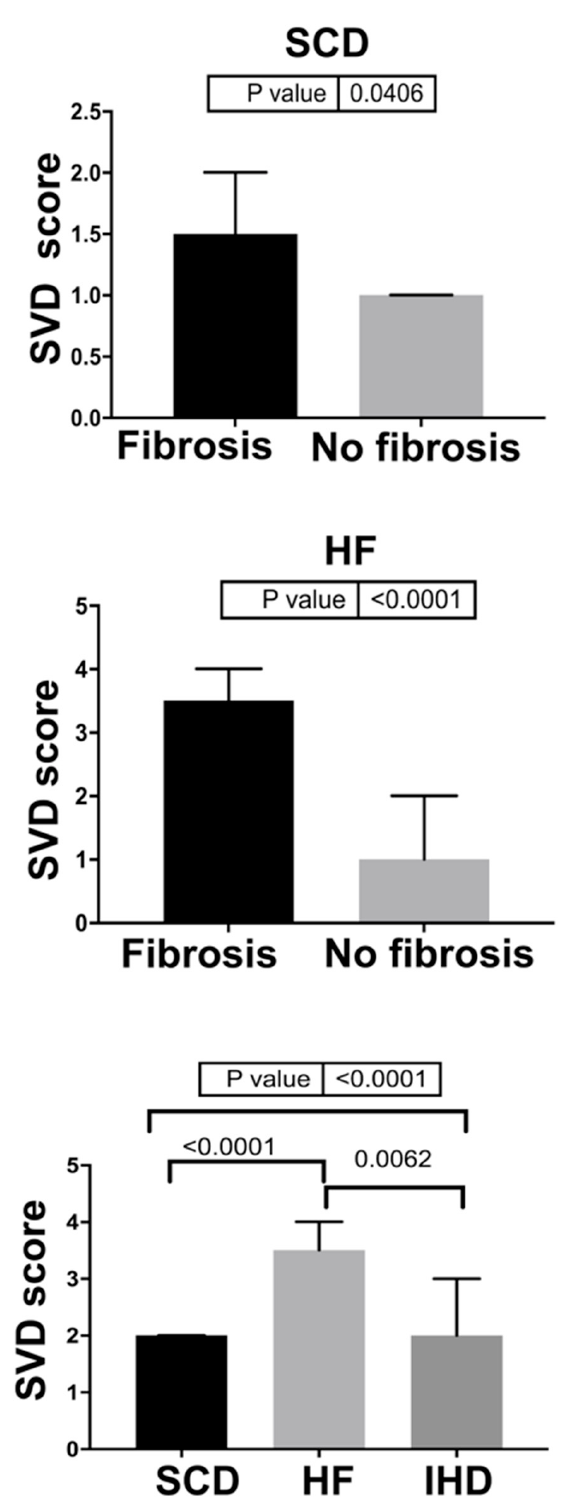
Figure 3. SVD score analyses in the study population. SCD-HCM with replacement-type fibrosis vs. without replacement-type fibrosis; HF-HCM with replacement-type fibrosis vs. without replacement-type fibrosis ( p value calculated by Mann–Whitney test); SCD-HCM vs. HF-HCM vs. IHD ( p values calculated by Kruskal–Wallis test).